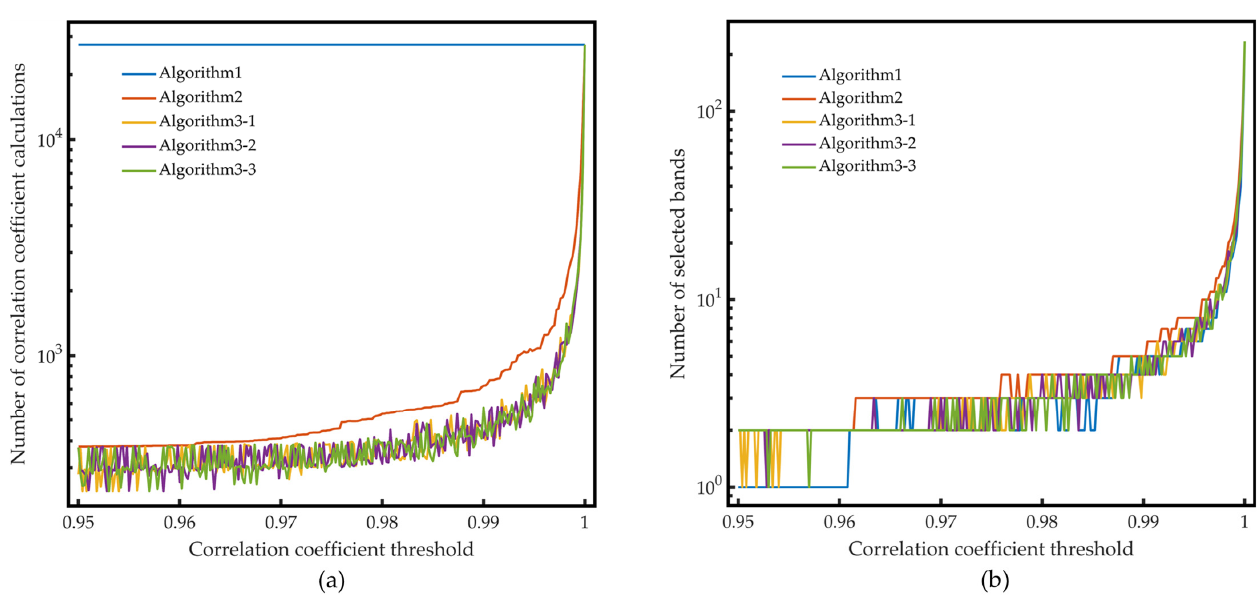
8 of 25 Figure 2. Correlation coefficients between the 235 bands. The correlation coefficients between 8 bands selected according to equal band num-